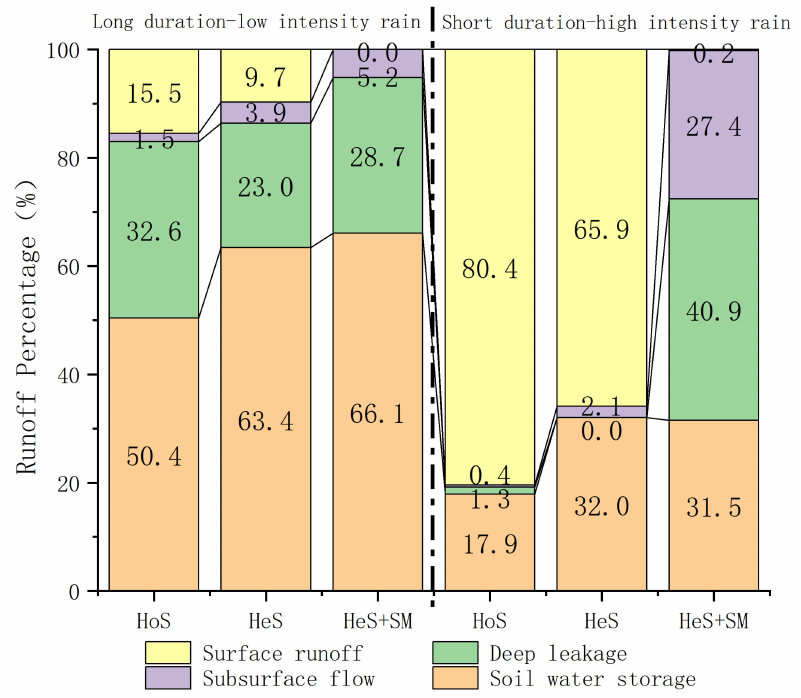
Figure 6. Surface runoff and subsurface flow under different rainfall patterns. HoS, Homogeneous soil. HeS, Heterogeneous soil. HeS + SM, Heterogeneous soil + Straw mulch. (The proportion is less than 1%, and the figure is not